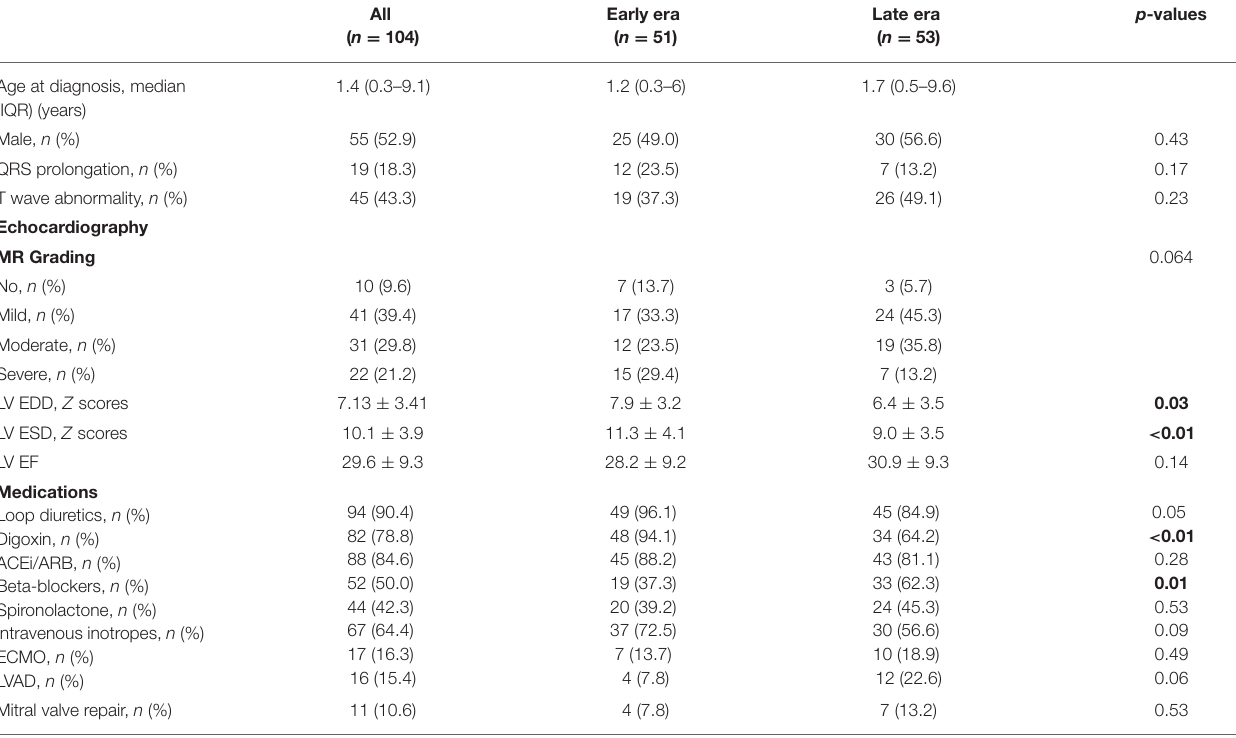
TABLE 1 | Demographic characteristics of the study population and comparisons between early and late eras.